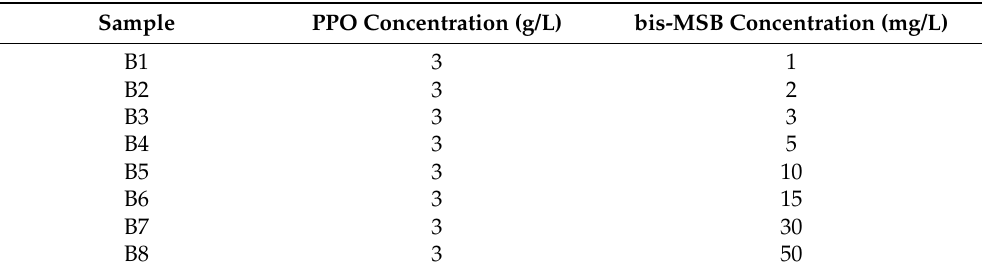
Table 2. LS with different PPO and bis-MSB concentrations. The concentration of PPO was optimized and kept constant at 3 g/L and the concentration of bis-MSB varied from 1 mg/L to 50 mg/L. Sample PPO Concentration (g/L)